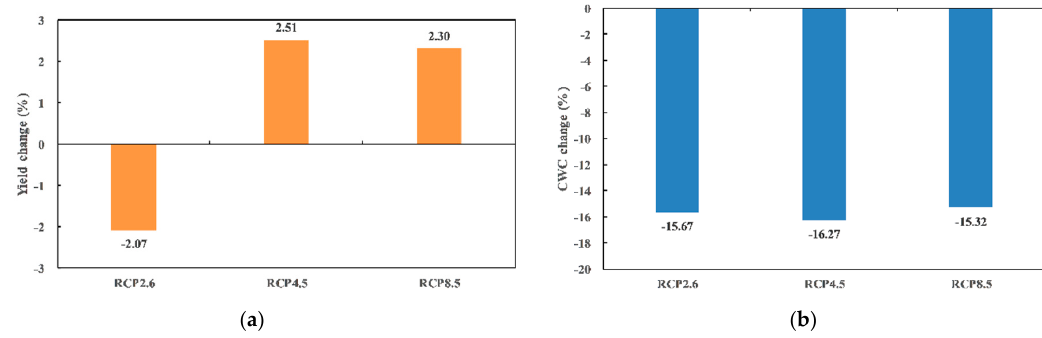
Figure 8. Changes of the mean annual ( a ) maize yield and ( b ) CWC in the Ganzhou area under the three RCP scenarios.